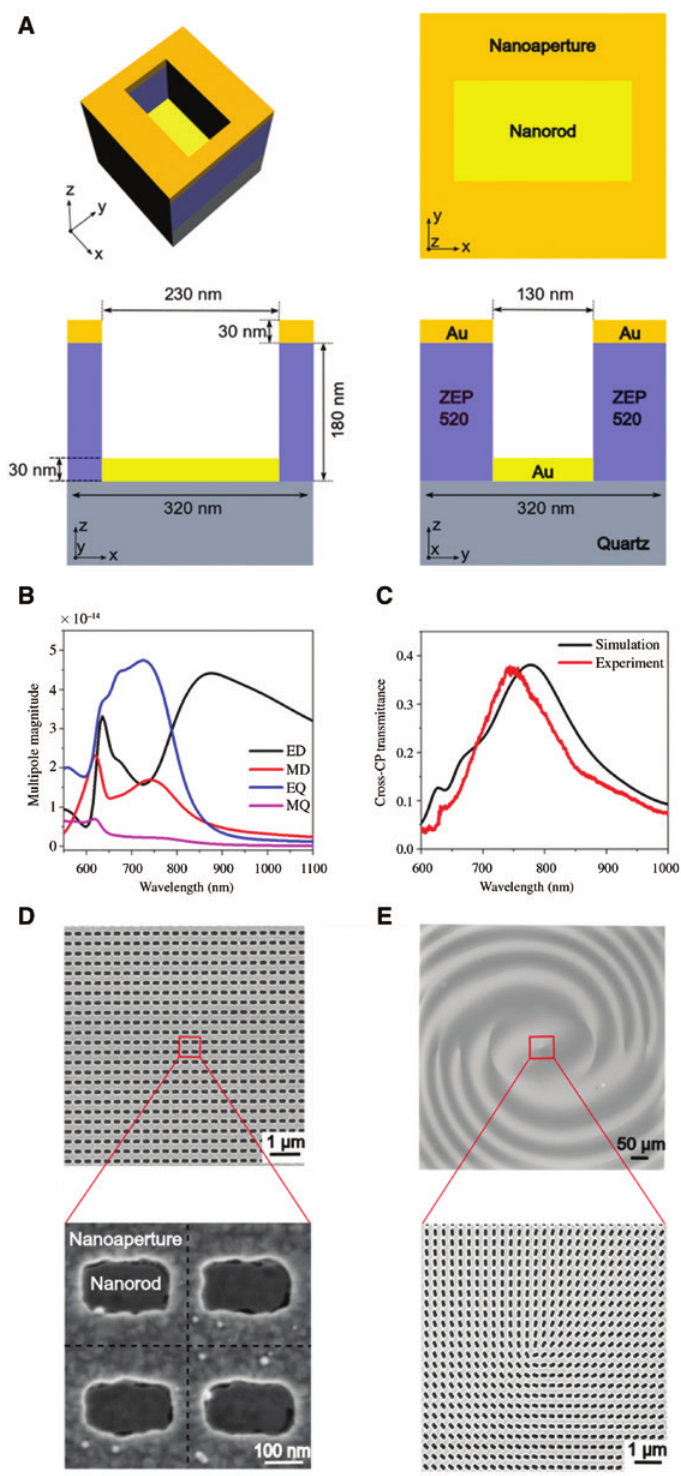
Figure 2: Meta-atom design and DH-metalens realization. (A) Schematic diagram of the plasmonic meta-atom. (B) Multipole analysis of the meta-atom with a CP input. The designed plasmonic meta- atom supports multipole moments, including electric dipole (ED), magnetic dipole (MD), electric quadrupole (EQ), and magnetic quadrupole (MQ). (C) Calculated and experimental cross-CP transmittance of the metasurface as a function of the wavelength. (D) SEM image of a general metasurface. The inset is the magnification of four meta-atoms, where two layers are clearly observable. (E) Microscope image of the fabricated DH-metalens. The inset is the SEM image of a representative antenna array at the center area of the